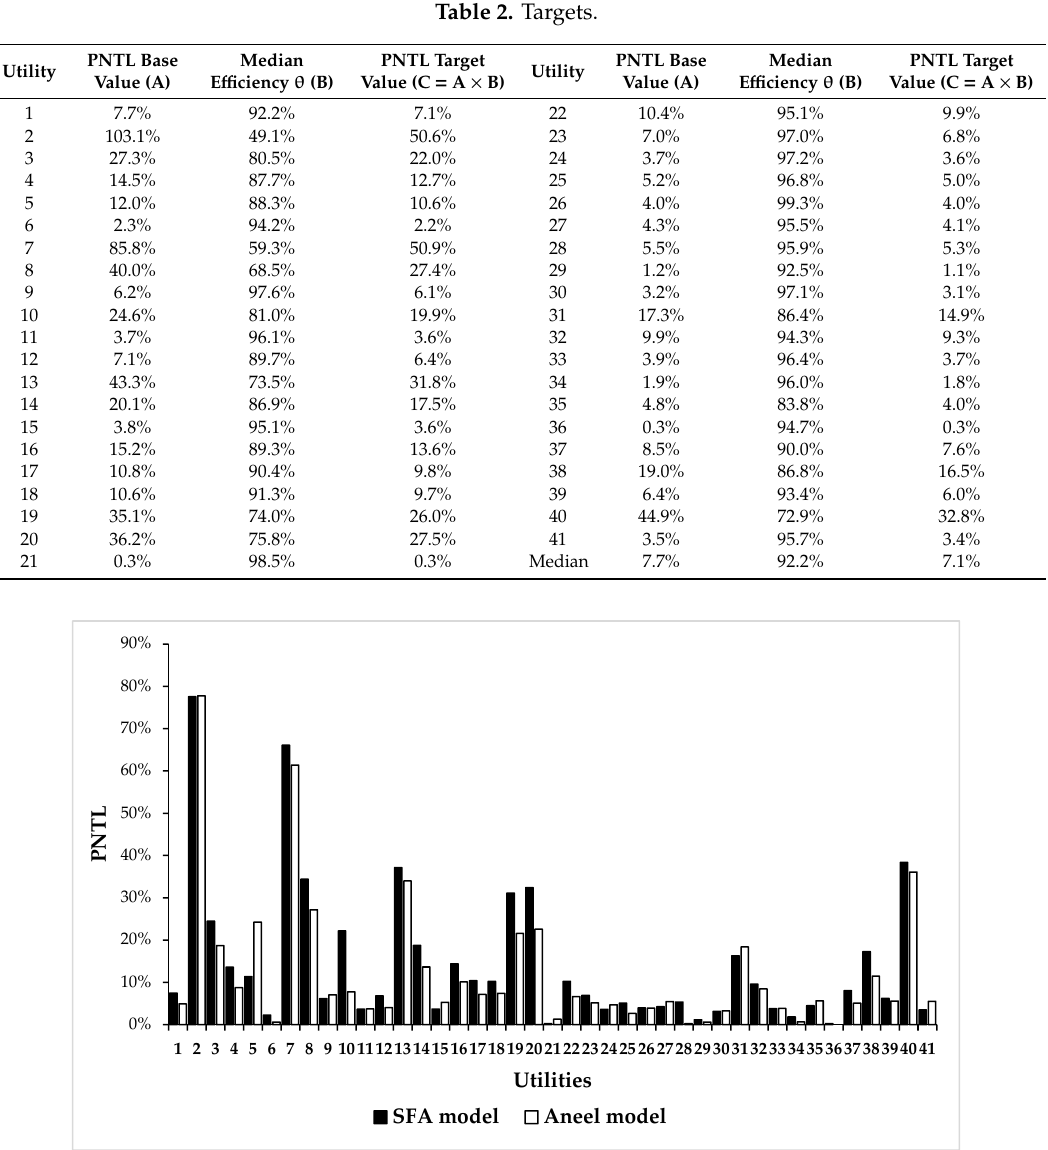
Figure 12. Boxplots of the PNTLs over the period of 2007–2016 and target values.